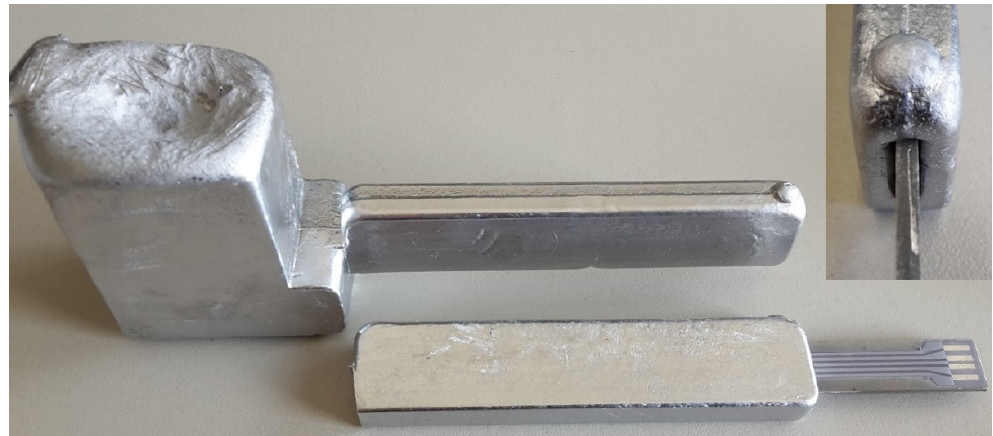
Figure 4. The filled cavity without the embedded sensor as well as the embedded sensor separated from the sprue (top right corner) in a detailed view of the protruding substrate.